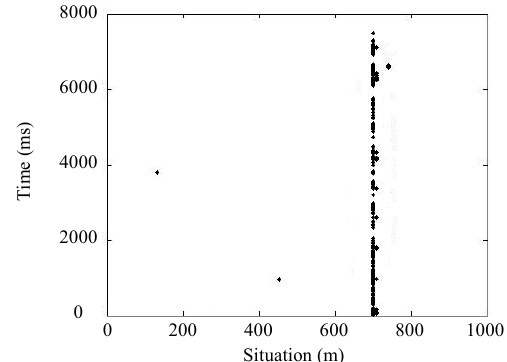
Fig. 11 Detection result of CFAR.